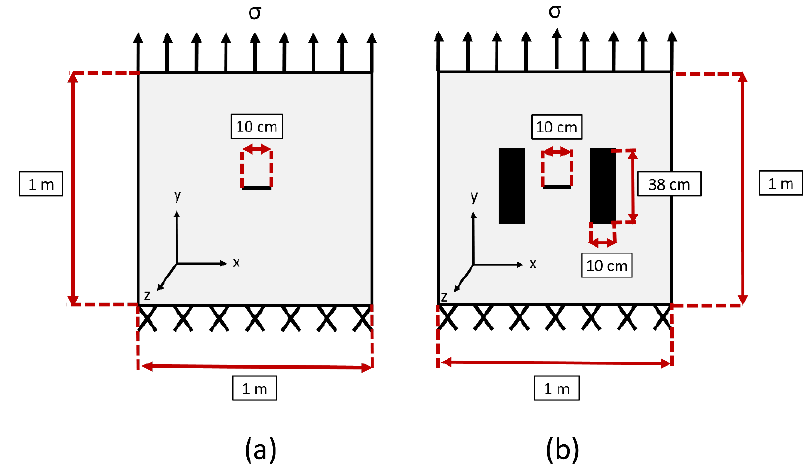
Figure 3. Large-scale steel plate specimen configuration ( a ) with CFRP Repairs; ( b ) without CFRP Repairs. Table 2. Material properties.